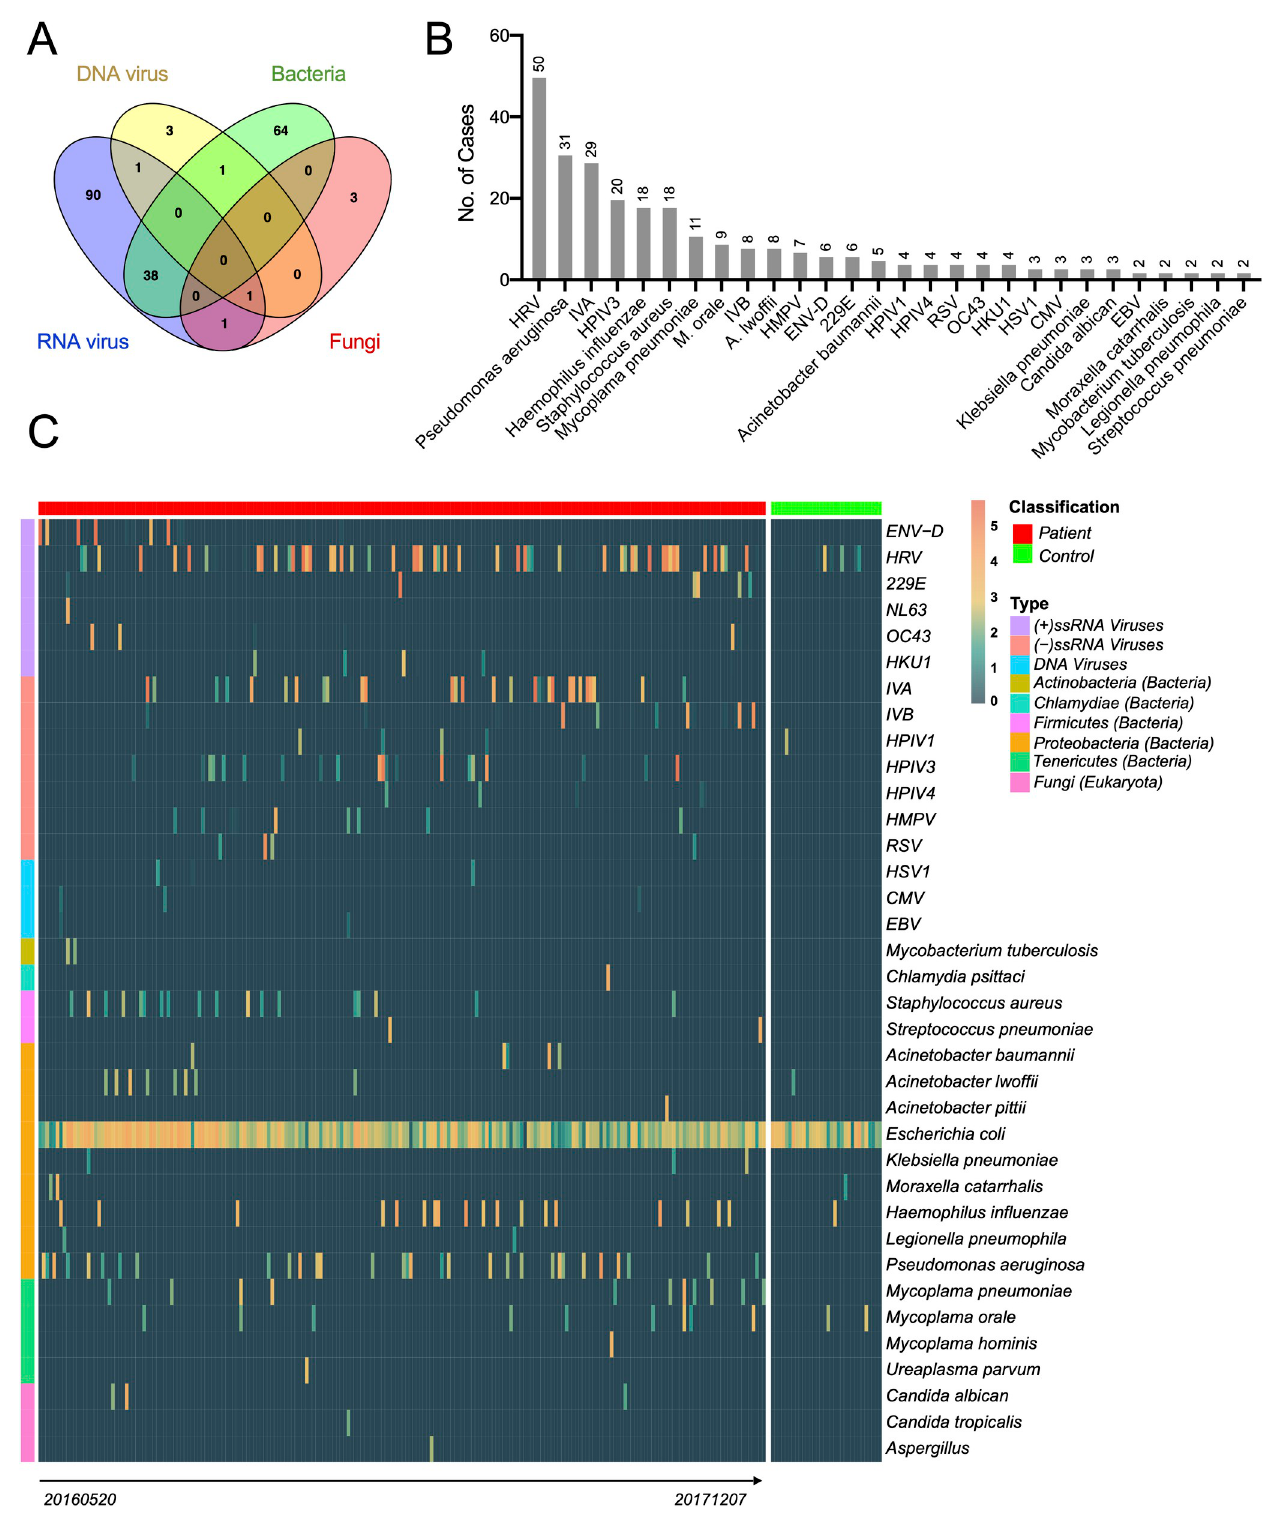
Fig 2. Prevalence and abundance of viral, bacterial and fungal pathogens in the 408 cases examined in this study. (A) Proportion of cases infected with RNA virus, DNA virus, bacteria, fungus and with mixed infections. (B) Prevalence of each pathogen, ordered by the number of cases. (C) Heat map showing the prevalence and abundance of pathogens in diseased and control samples. Escherichia coli is not regarded as pathogen but is shown here as an example of non-pathogen contamination. The samples (x-axis) are divided into “Patient” and “Control” groups, each ordered chronically. The pathogens (y-axis) are divided into four categories: RNA viruses, DNA viruses, bacteria, and fungi.